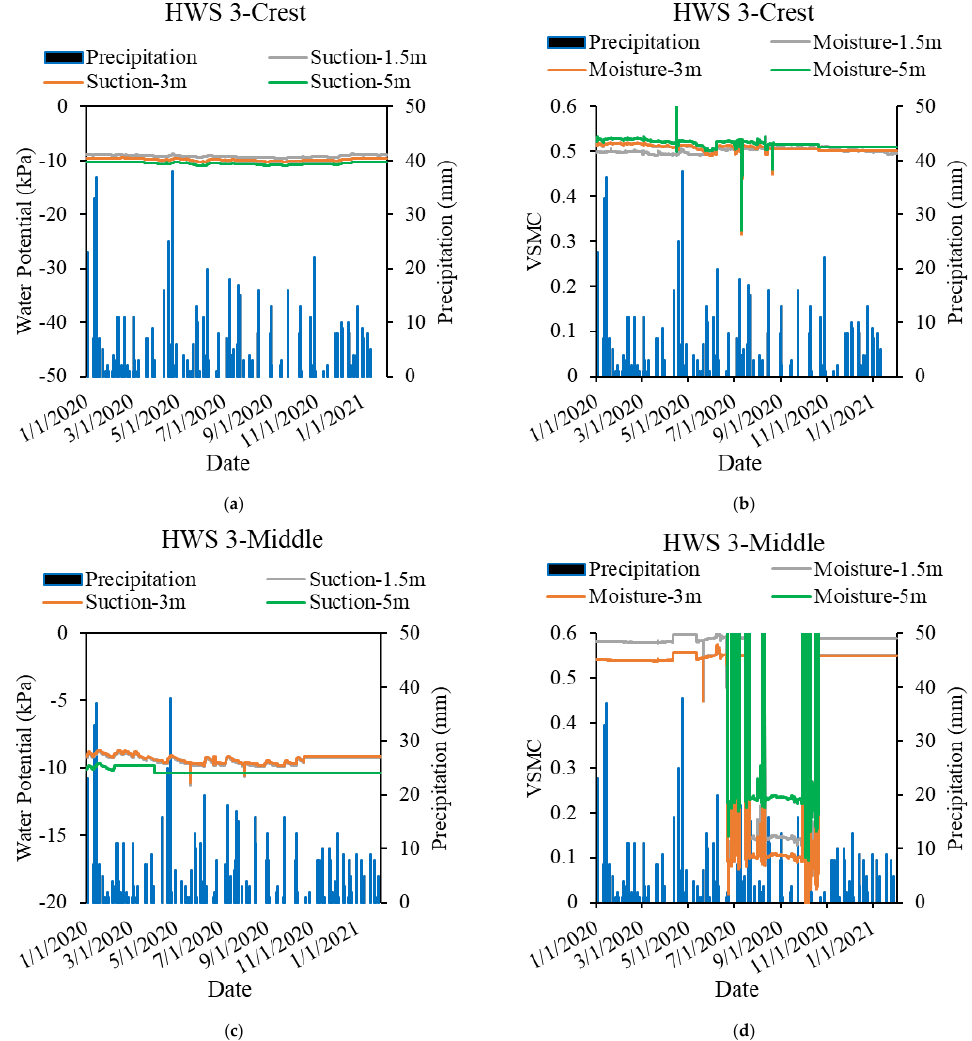
Figure 17. HWS 3 in situ variations with rainfall ( a ) SMS across the crest of the slope ( b ) VSMC across the crest of the slope ( c ) SMS across the middle of the slope ( d ) VSMC across the middle of the slope (1 m = 3.28 ft; 1 mm = 0.039 in; 1 kPa = 20.89